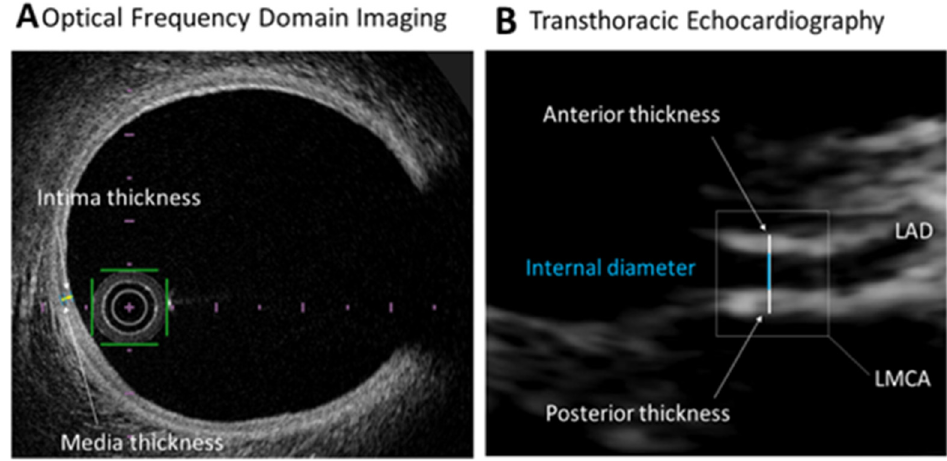
Figure 1. ( A , B ) LMCA measurements by optical frequency domain imaging (OFDI) and transtho ‐ racic echocardiography (TTE). LAD: left anterior descending, LMCA: left main coronary artery.